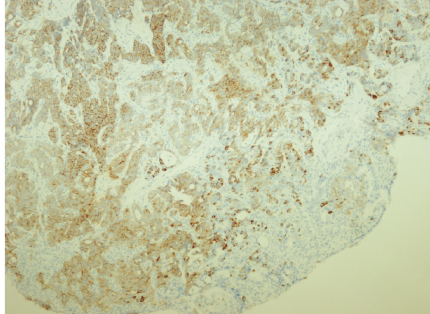
Figure 2: Synaptophysin immunostaining of tumour cells (brown